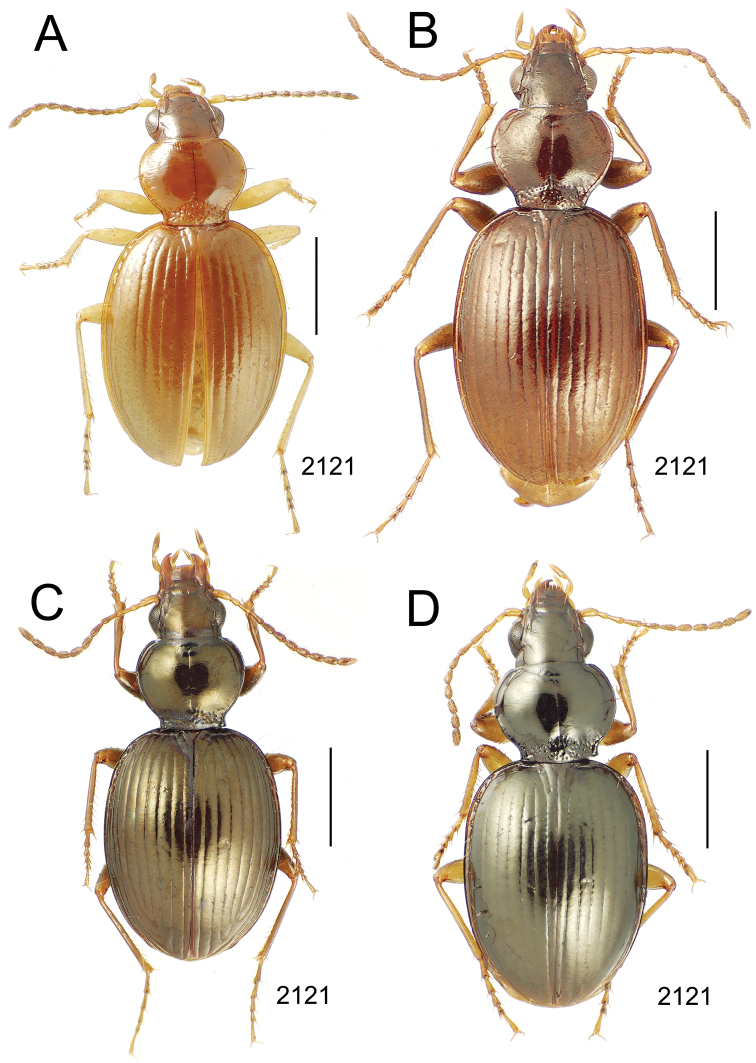
Mecyclothorax spp., dorsal view; scale bars 1.0 mm; setal formula (see Fig. 10) at lower right of each figure A
Mecyclothorax externestriatus teneral female B
Mecyclothorax pirihao paratype male (CUIC) C
Mecyclothorax spinosus paratype female (MNHN) D
Mecyclothorax poro holotype female.